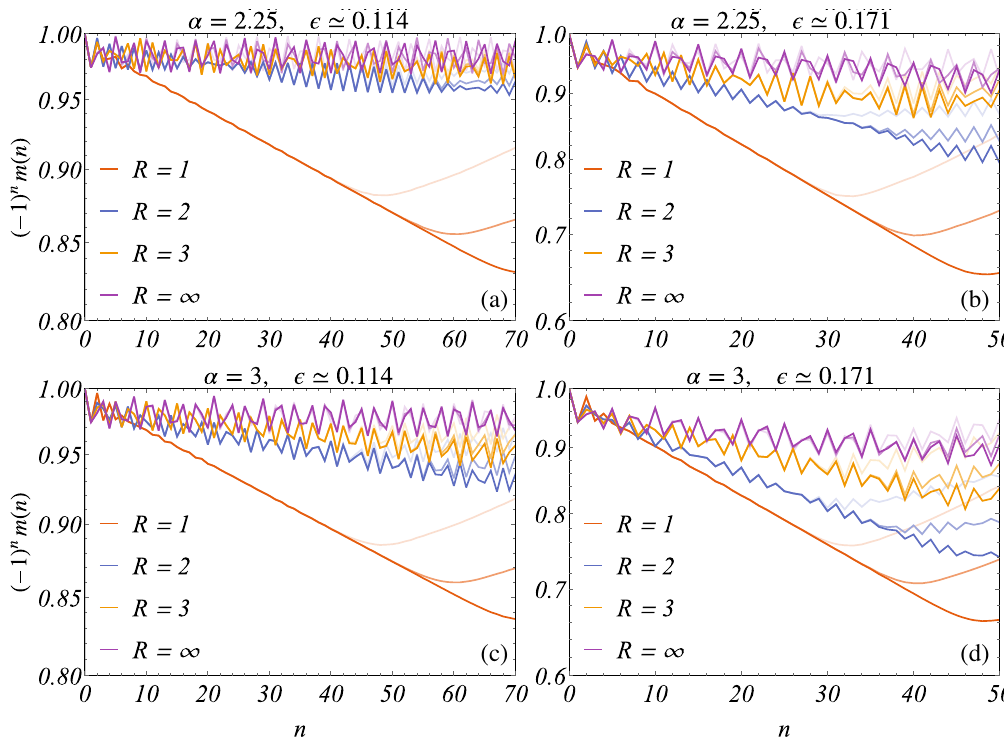
FIG. 14. Order-parameter decay for increasing interaction range R of the Ising couplings, from nearest-neighbor ( R ¼ 1 ) to long-range ( R ¼ ∞ ) interactions, as indicated in the legends. Data are from ED simulations for chains of length L ¼ 20 , 25, 30 (shaded lines from lighter to darker). The various panels represent different values of the decay exponent α and of the kick strength ϵ . Note that a strong ≪ ϵ , i.e., well beyond the strict perimeter of our analytical stabilization of the DTC response occurs even for J r> 1